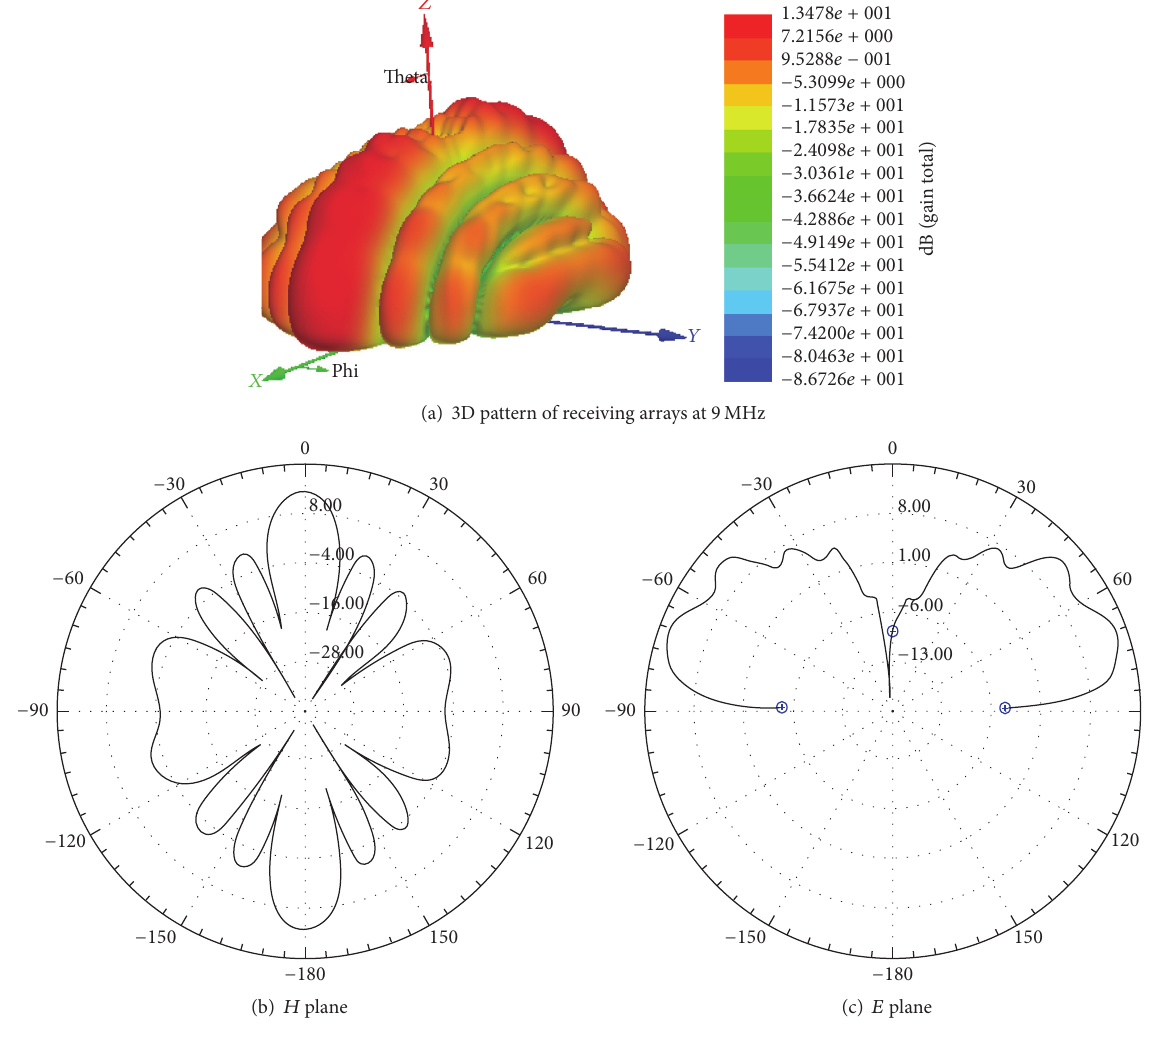
Figure 6: Pattern of vertically polarized antenna receiving arrays at 9MHz. The element length is 6.5 m. 𝑑 1 = 14.5 m and 𝑑 2 = 8 m. The copper ground screen is about 100m 2 . The diameter of grid is